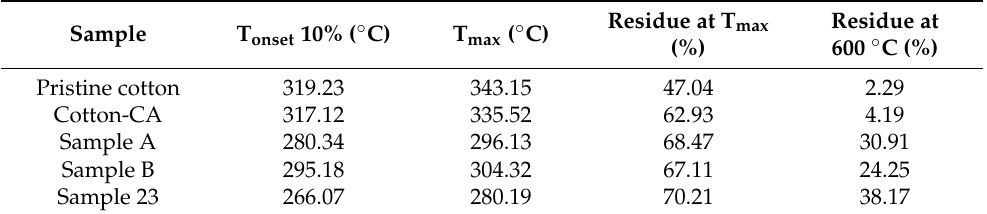
Table 3. Thermal characteristics of pristine cotton and developed samples.